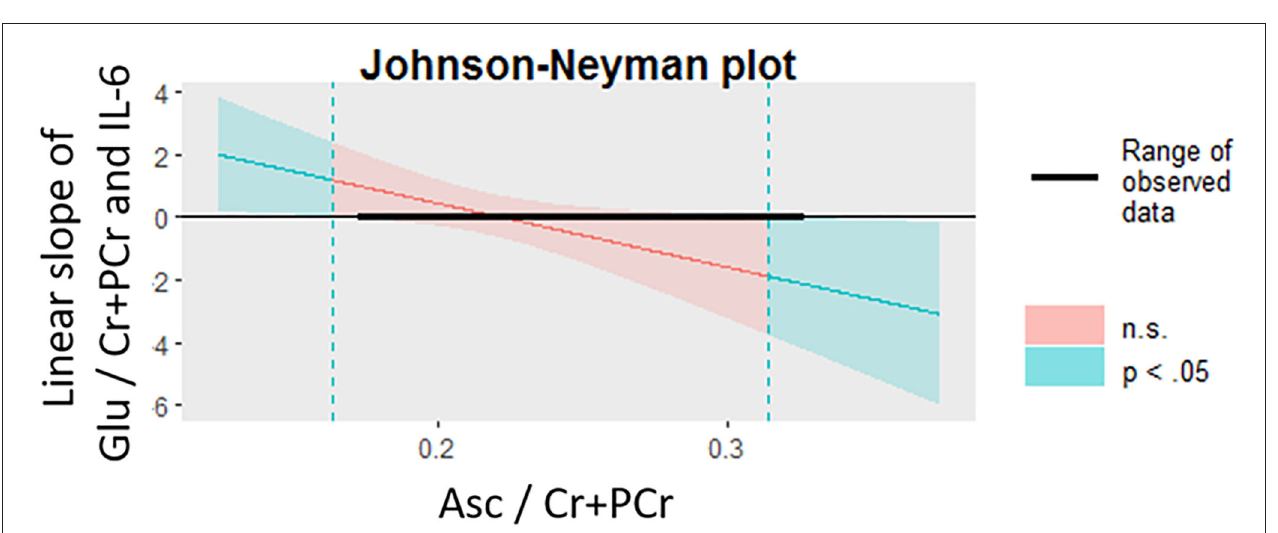
FIGURE 4 | Levels of Asc in the dACC moderate the association between IL-6 and glutamate in the dACC. The Johnson-Neyman procedure was used to probe the interaction effect of dACC Asc and IL-6 on dACC Glu. At lower levels of Asc ( < 0.16, indicated by dotted teal line, left), the correlation between IL-6 and Glu was significantly positive ( p < 0.05) whereas at higher levels of Asc ( > 0.32, indicated by dotted teal line, right), the correlation between IL-6 and Glu was significantly negative ( p < 0.05). Asc, ascorbate; dACC, dorsal anterior cingulate cortex; Glu, glutamate; IL-6, interleukin-6.